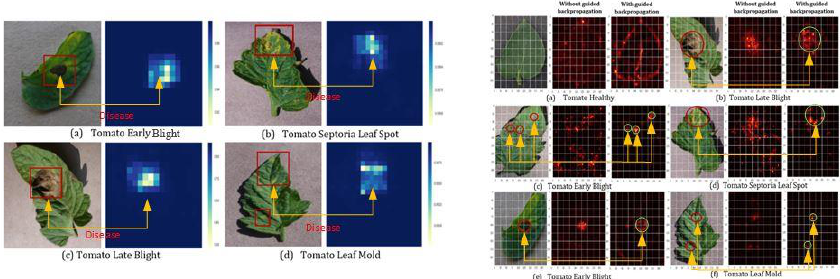
Figure 5. Tomato plant disease detection by heat map: on left hand side ( a ) tomato early blight, ( b ) tomato septoria leaf spot, ( c ) tomato late blight and ( d ) tomato leaf mold) and saliency map; on right hand side ( a ) tomato healthy, ( b ) tomato late blight, ( c ) tomato early blight, ( d ) tomato septoria leaf spot, ( e ) tomato early blight, ( f ) tomato leaf mold) [55].